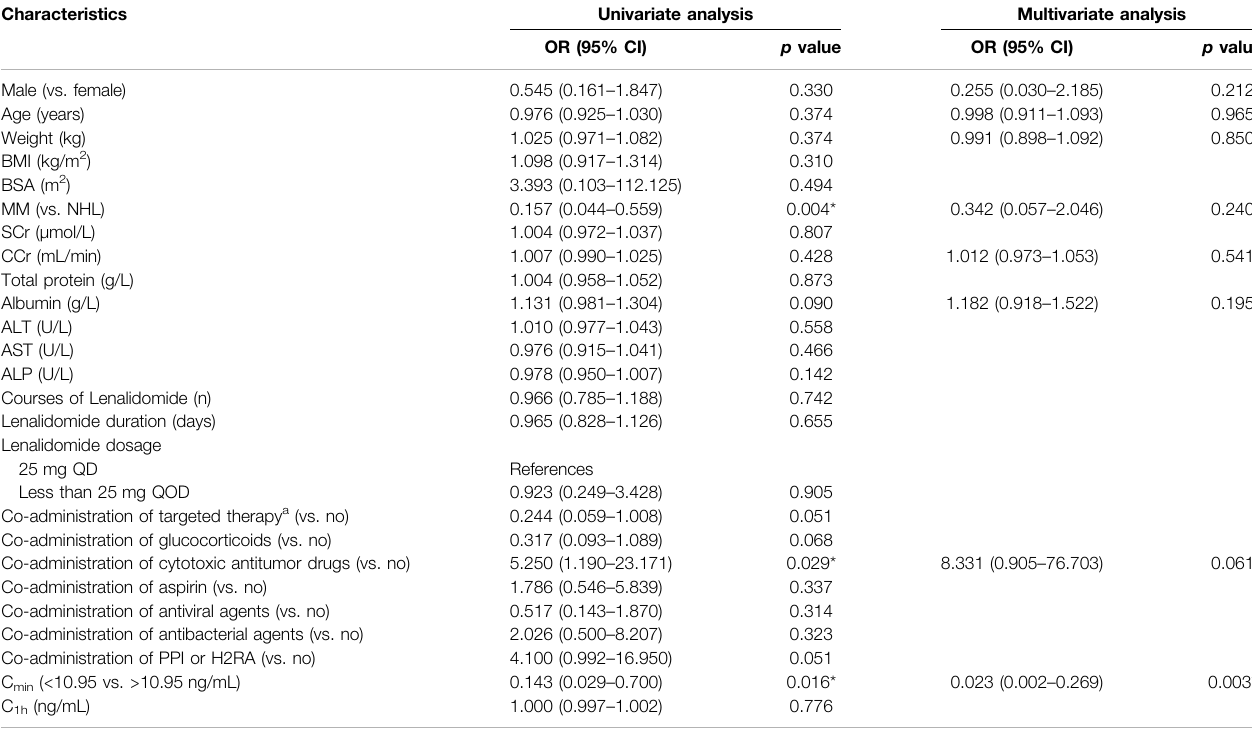
TABLE 2 | Univariate and multivariate analyses of factors in fl uencing hematological toxicity.